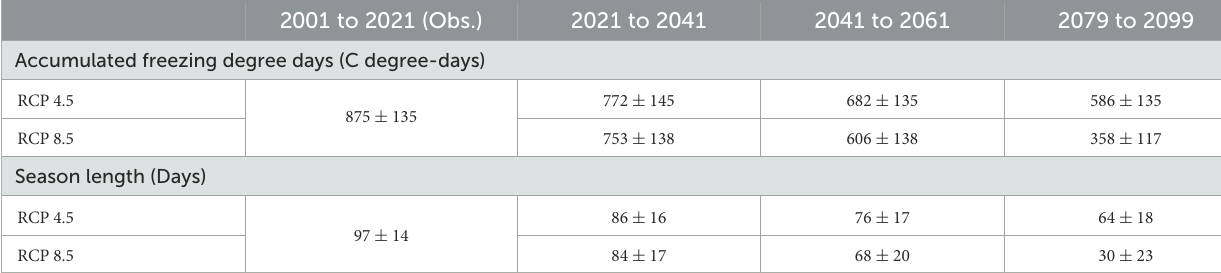
TABLE 1 Results of simulations for AFDD and Days 0 C transformed to season length at Pinkham Station under RCPs 4.5 and 8.5. 2001 to 2021